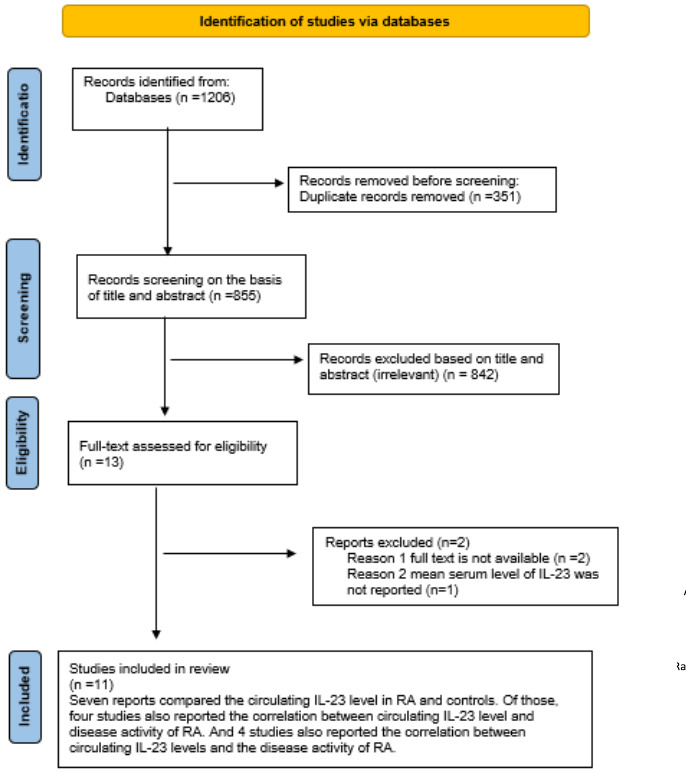
Figure1 : Flow chart depicting the selection of publications